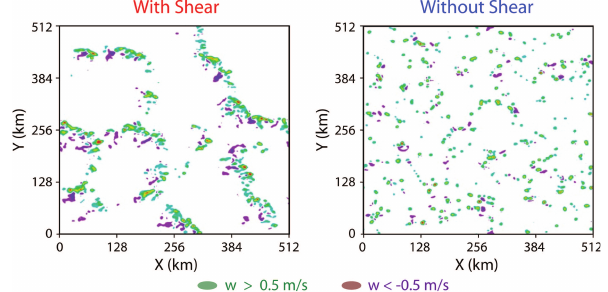
Fig. 6. Snapshots of vertical velocity w at 3km height at the end of two simulations with and without background